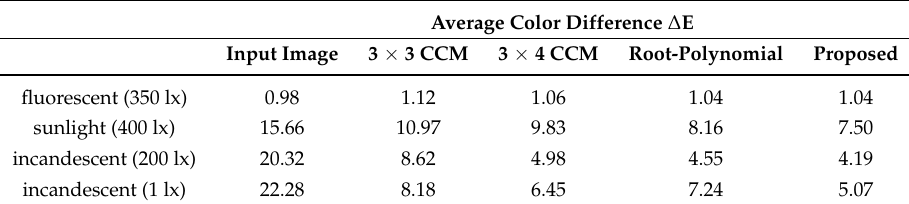
Table 4. Average color difference, ∆ E.